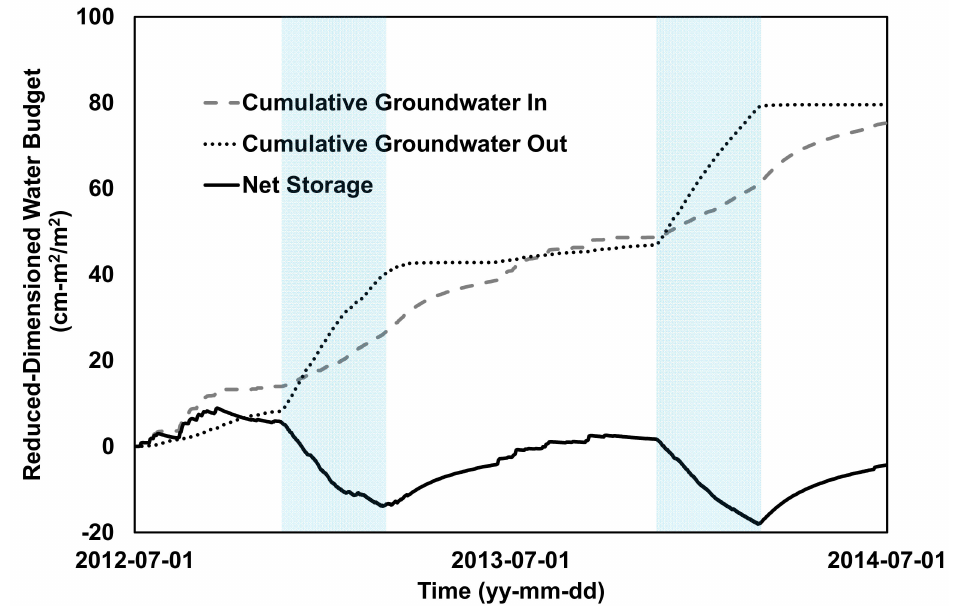
Figure 7. Cumulative water budget plot for aquifer from September 2012 to June 2014 (blue boxes represent WCC